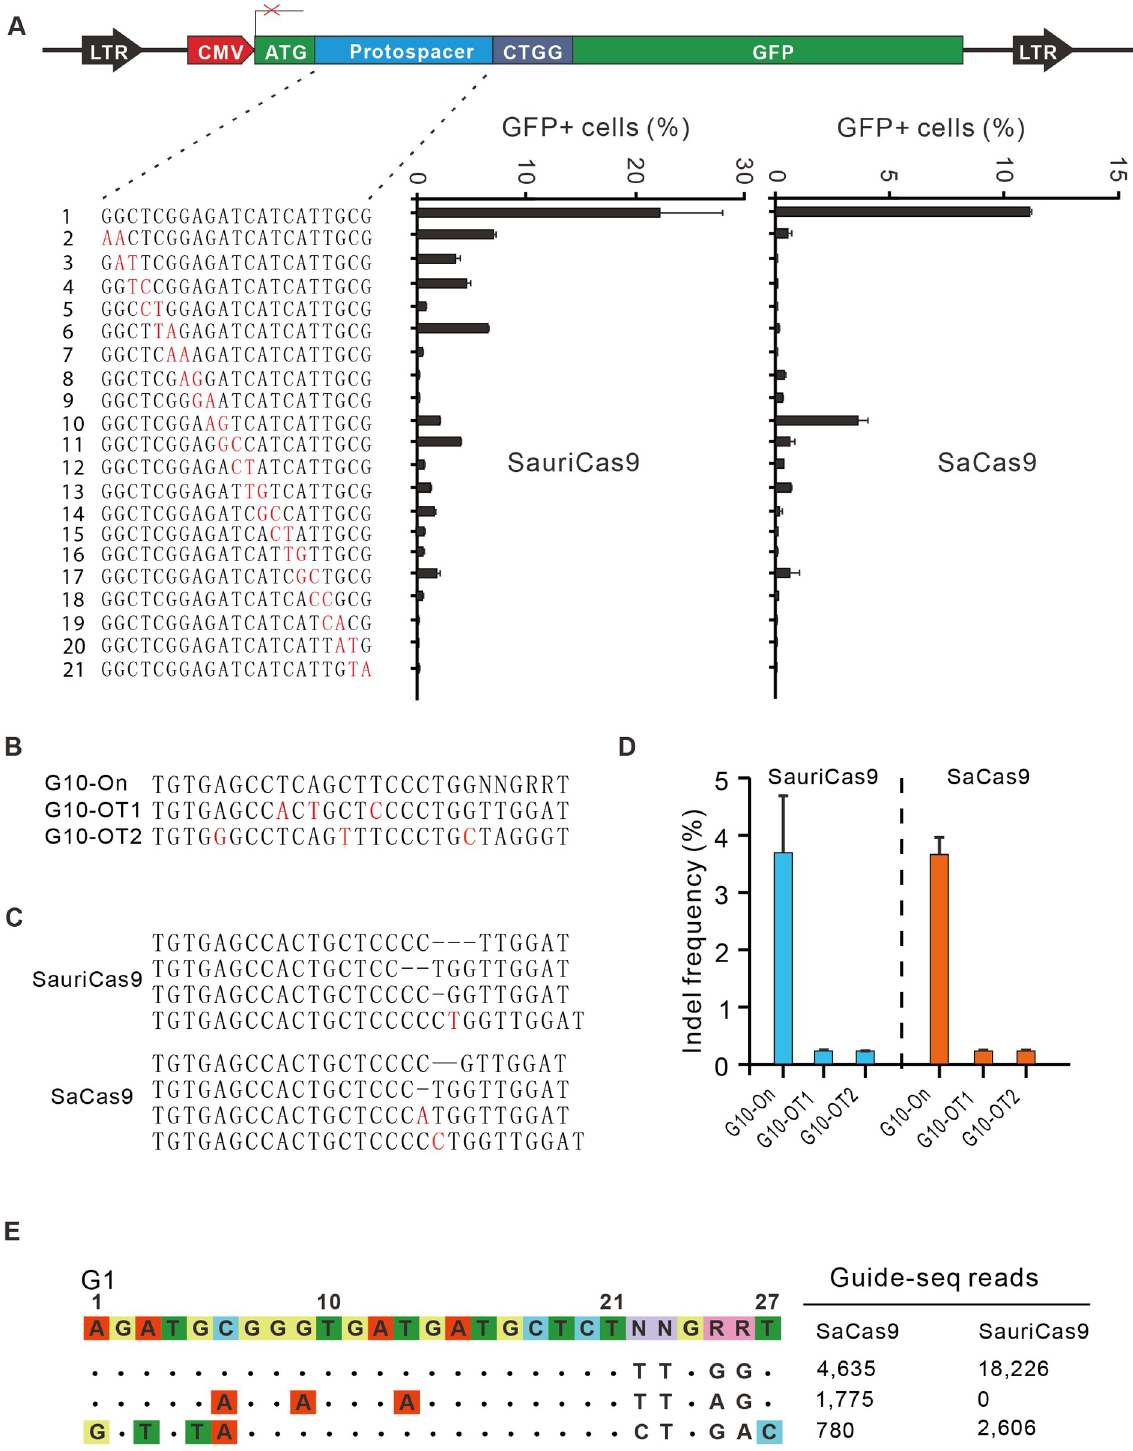
Fig 5. Analysis of SauriCas9 specificity. (A) A target sequence is inserted between ATG and GFP coding sequence, disrupting GFP expression. Target cleavage will induce GFP expression. Underlying data for all summary statistics can be found in S1 Data. A panel of gRNAs with dinucleotide mismatches (red) and each gRNA activity are shown below. (B) Two potential off-target sequences are selected for targeted deep-sequencing analysis. Mismatches are shown in red. (C) Indel sequences are detected by deep sequencing. (D) Indel frequencies detected by targeted deep sequencing ( n = 2). Underlying data for all summary statistics can be found in S1 Data. (E) Off-targets for G1 locus are